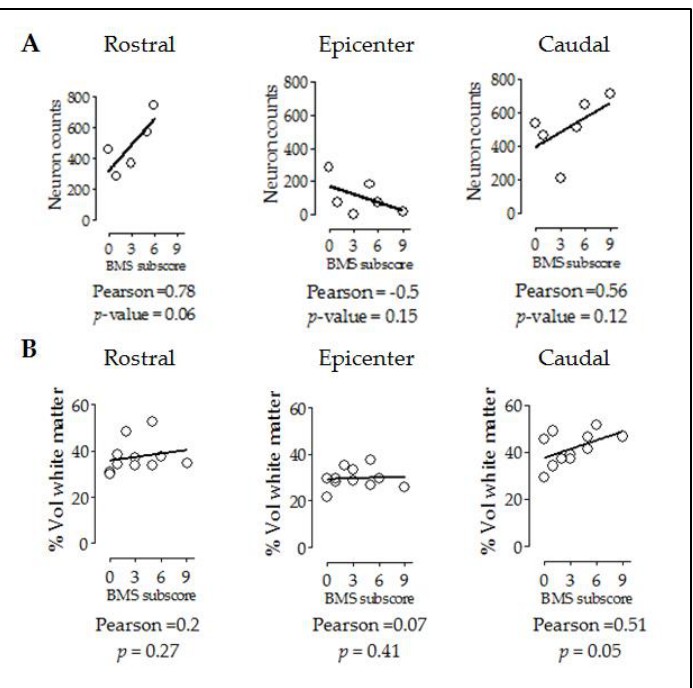
Figure 5. Improvement in locomotor capacities by overexpression of hXIAP after SCI correlates with both neuron counts and tissue preservation levels. Dot-plot correlating BMS subscores with neuron counts ( A ) and preserved white matter volumes ( B ) at different distances from the injury site. Lines represent the correlation fit of both CB57 WT and CB57 hXIAP+ animal data altogether. Additionally, subscores were not correlated to rostral or epicentre levels (Figure 5B) (epicentre: PCC = 0.07, p- value= 0.41; rostral: PCC = 0.2, p- value= 0.27) but significantly correlated at caudal level (PCC = 0.51, p- value= 0.05).